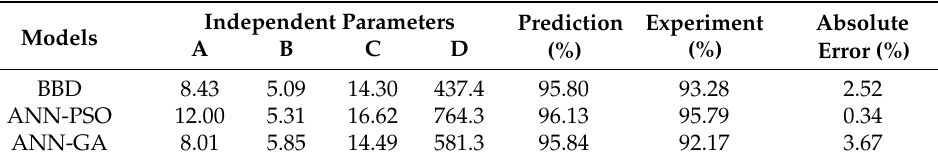
Table 8. Comparison of the predicted percentage of decontamination of carmine by the BBD, ANN- PSO and ANN-GA models with the experimental results.